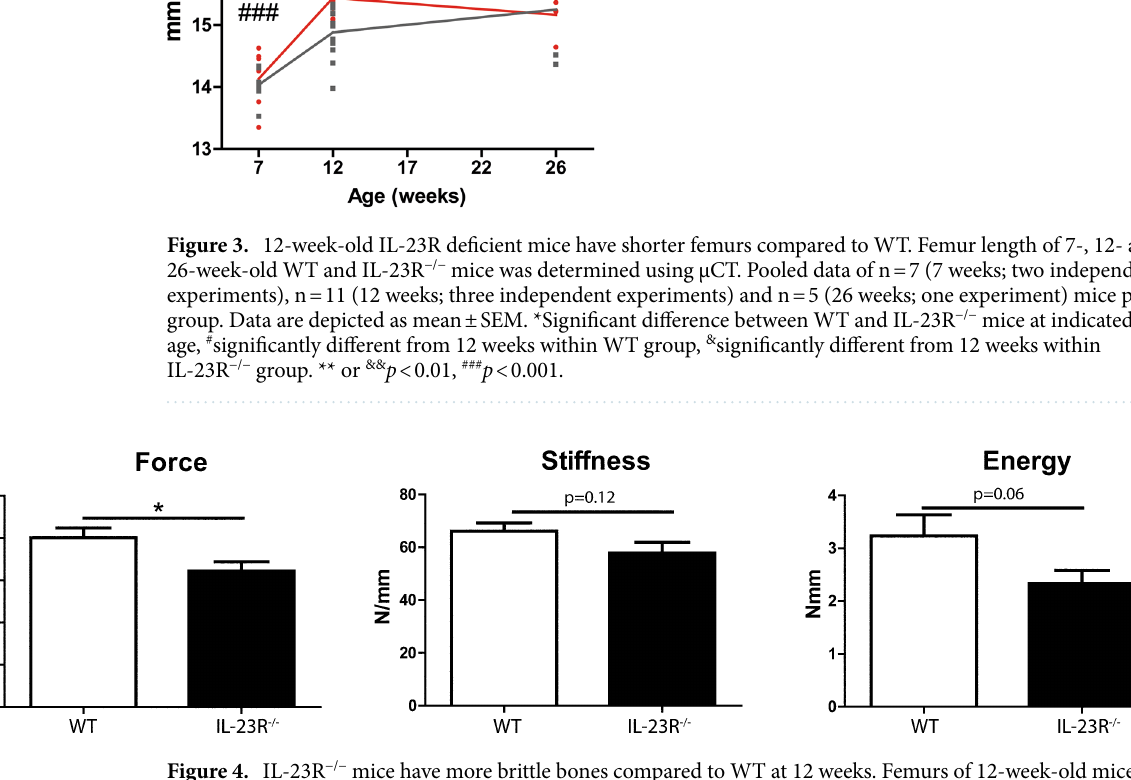
Figure 4. IL-23R −/− mice have more brittle bones compared to WT at 12 weeks. Femurs of 12-week-old mice were subjected to three-point bending test for assessing bone strength. Pooled data of three independent experiments with n = 10–11 mice per group. Data are depicted as mean ± SEM. *p < 0.05